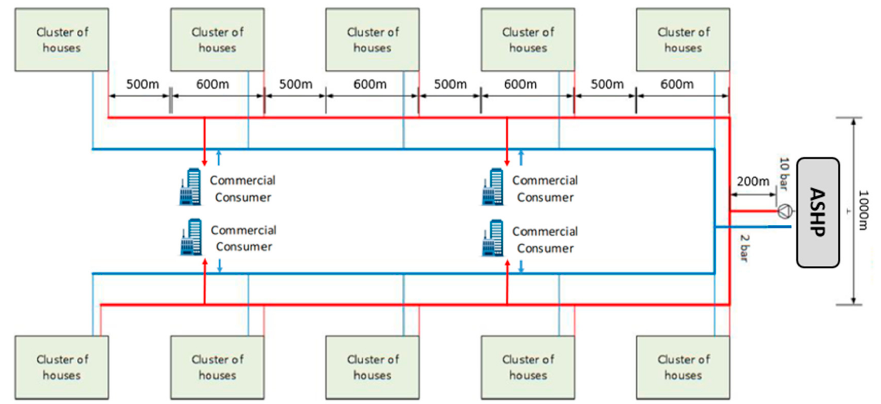
Figure 6. Tree network schematics for the assumed area.